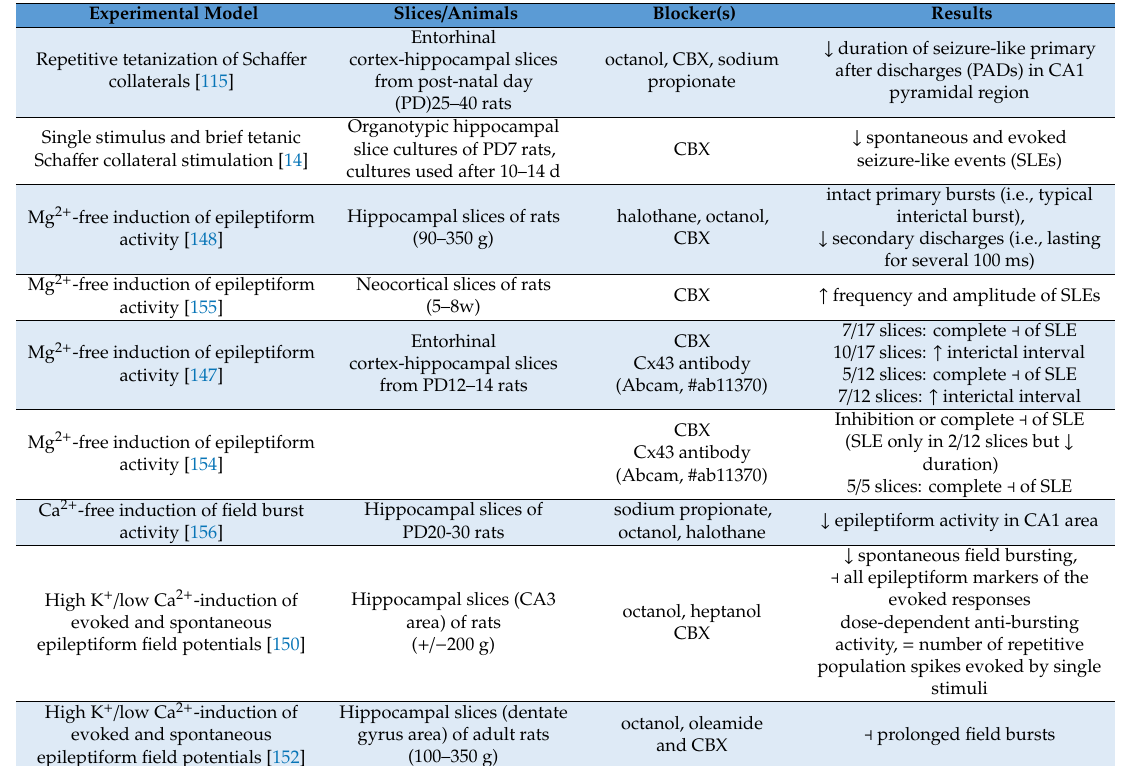
Table 4. E ff ects of non-selective gap junction blockers in in vitro seizure